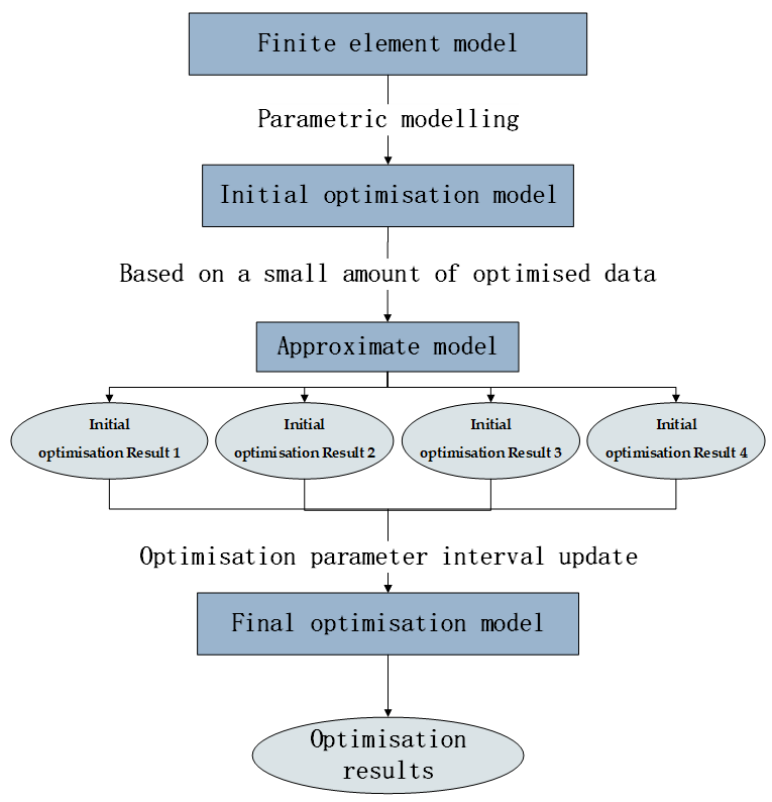
Figure 4. Rapid modelling of finite elements.